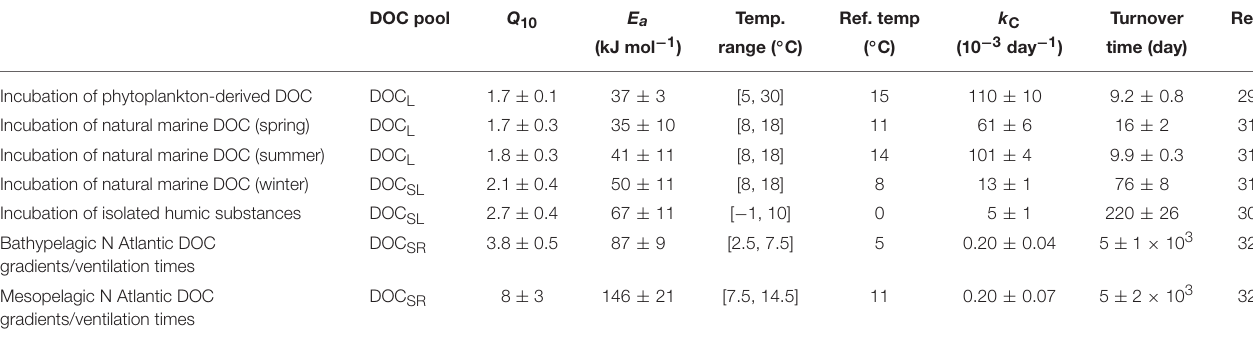
TABLE 1 | Summary of values obtained applying the Arrhenius law to experimental DOC degradation. DOC pool Q 10 E a Temp. Ref. temp k C Turnover Ref. (kJ mol − 1